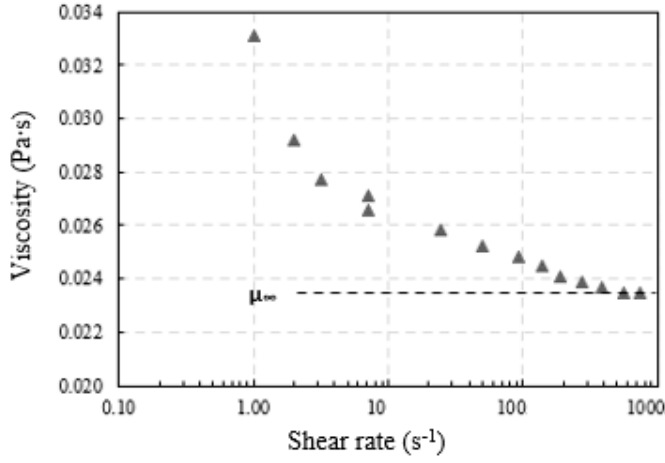
Figure 2. Viscosity versus shear rate for non-Newtonian fluid G2.